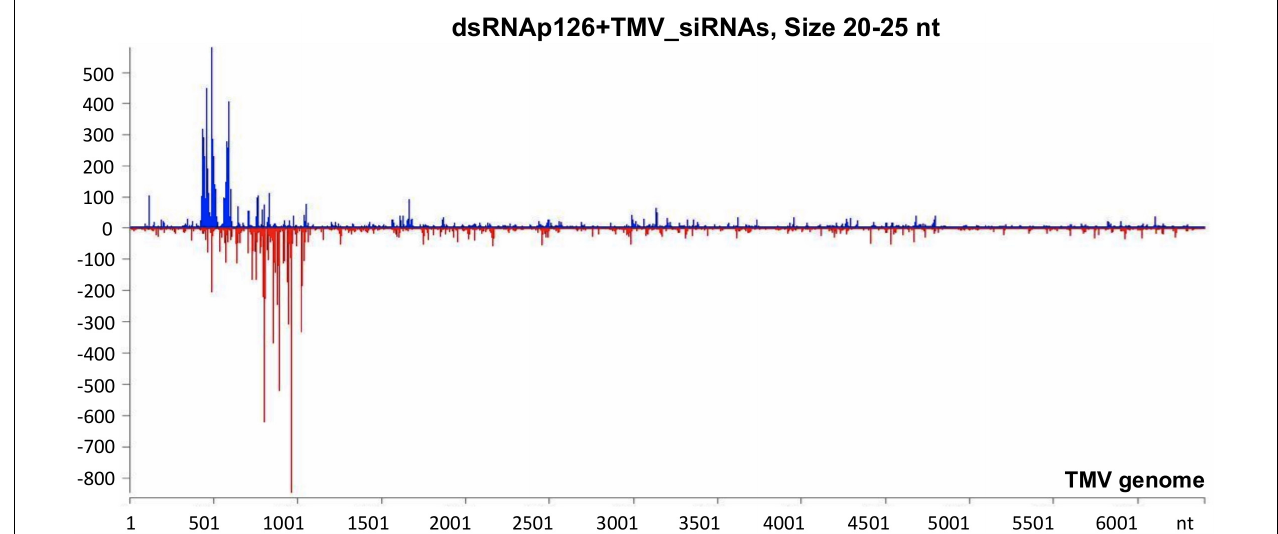
FIGURE 5 | Analysis of siRNAs produced in dsRNAp126 + TMV treatment at 15 min post inoculation (mpi) employing small RNA NGS. MISIS software visualization shows the distribution of siRNAs having 20–25 nt length along the sequence of a TMV reference genome (NC_001367.1). On the y -axis are shown the total read counts of siRNAs. Sense strand reads are shown with blue color above the x -axis, and antisense strand reads are shown with red color below the x -axis. In the region 426–1,091 of the TMV genome, the majority of reads could be derived from the exogenously applied dsRNAp126. Outside this region, the reads represent TMV-derived